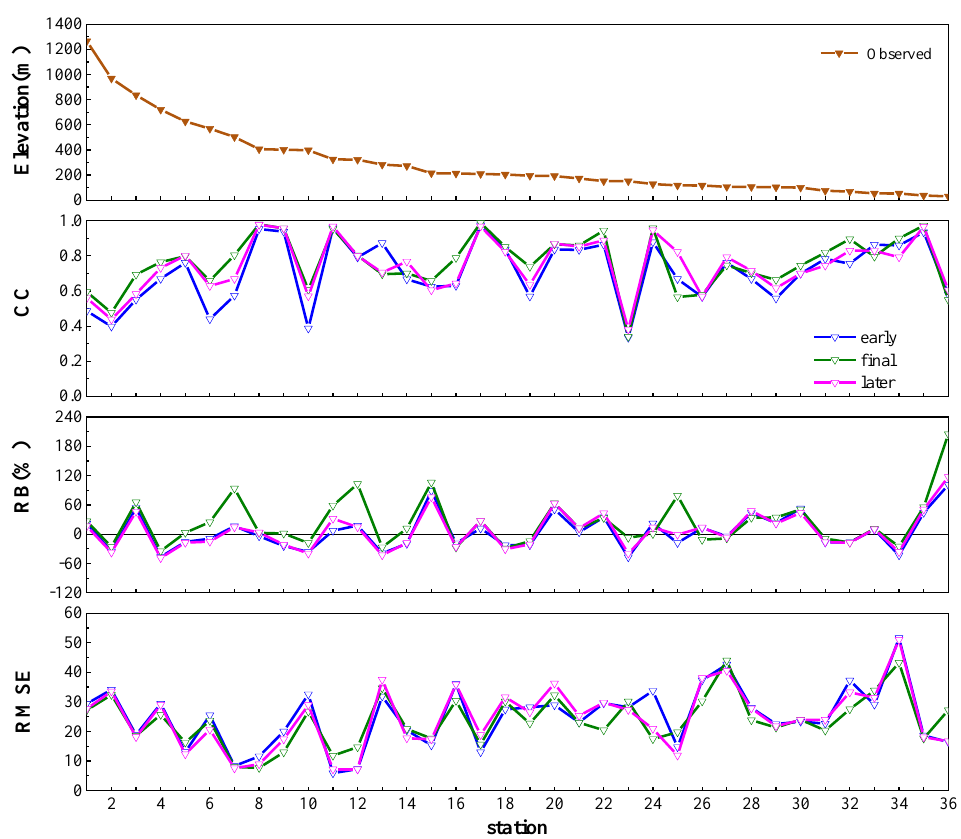
Figure 11. Comparison of daily precipitation between the IPPs and observed precipitation and three statistical metrics for 36 meteorological stations from 22 June and 4 July in 2017.